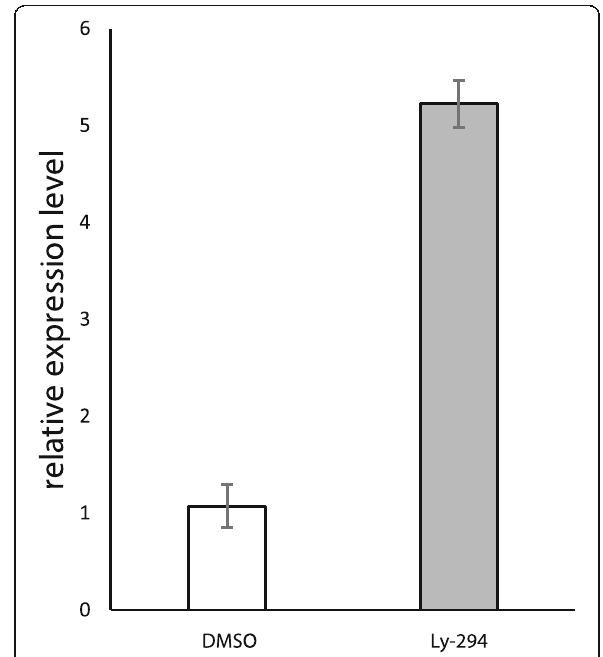
Fig. 5 Effect of Ly-294,002 treatment on bapx1 expression in Xenopus laevis at NF 45. Expression levels were determined through relative quantification (Livak method). Error bars indicate standard deviation of PCR runs ( n = 3). DMSO reared specimens show no significant reduction in expression compared to control specimens. Ly-294,002 treated specimens show a ~5 times higher expression level of bapx1 in comparison to